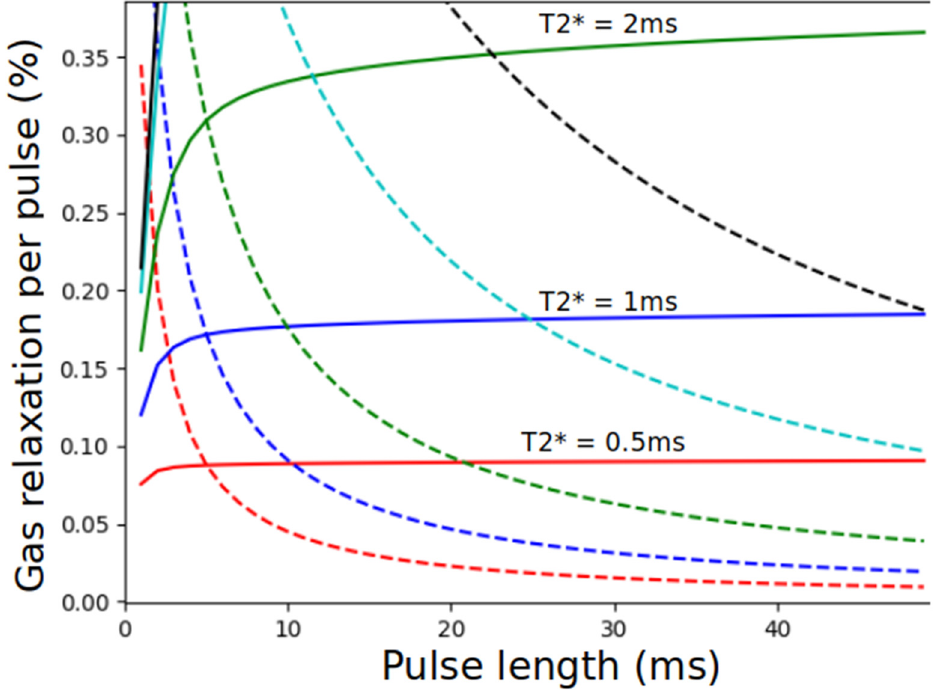
Figure 25. A Bloch simulation of the response to XTC (saturation) pulses shows that the extent of gas phase relaxation is largely independent of pulse length for pulses significantly exceeding the dissolved component T2* if the average pulse train power is held constant (solid traces) but not if the total flip angle is held constant (dashed traces). The figure is zoomed in to highlight behavior for the range of T2* (0.5–2 ms) likely to be encountered in clinical or preclinical imaging studies from 1.5 T to 9.4 T.